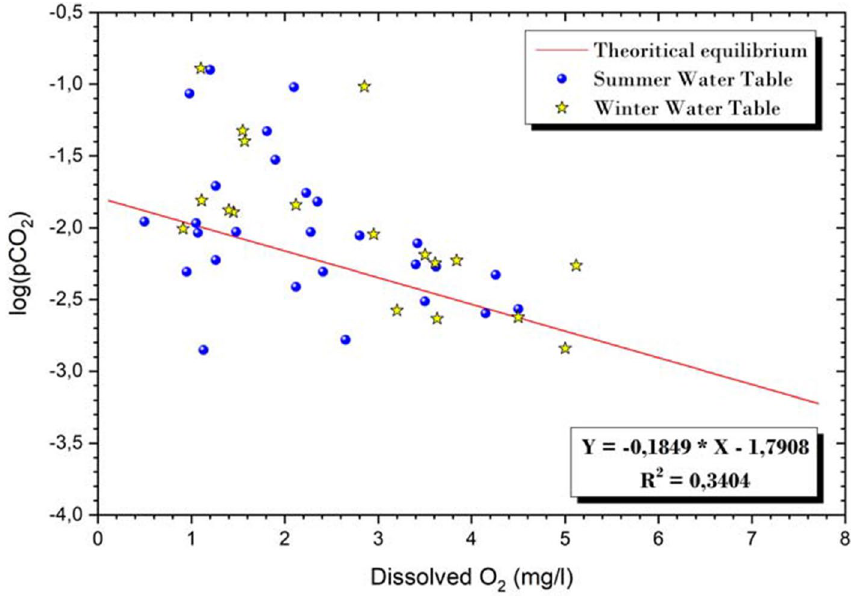
Fig. 4 Relationship between dissolved oxygen (O 2 ) and log(pCO